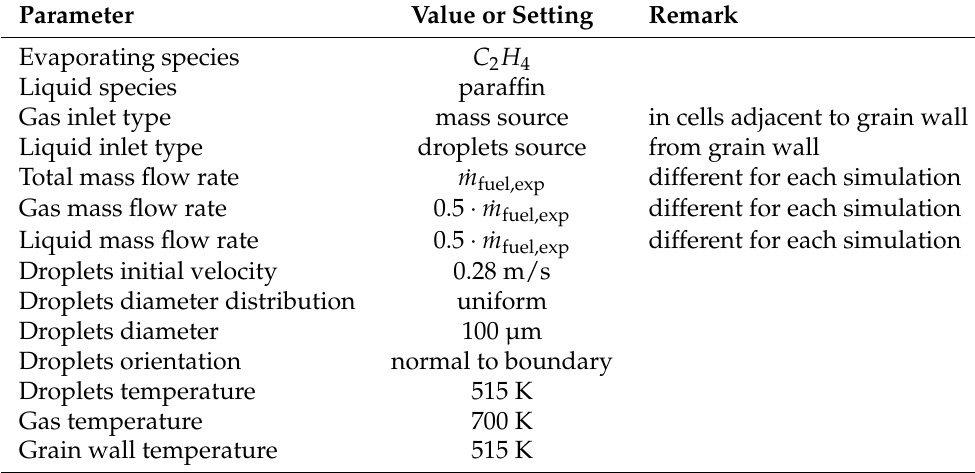
Table 5. Summary of fuel inlet boundary conditions for the baseline